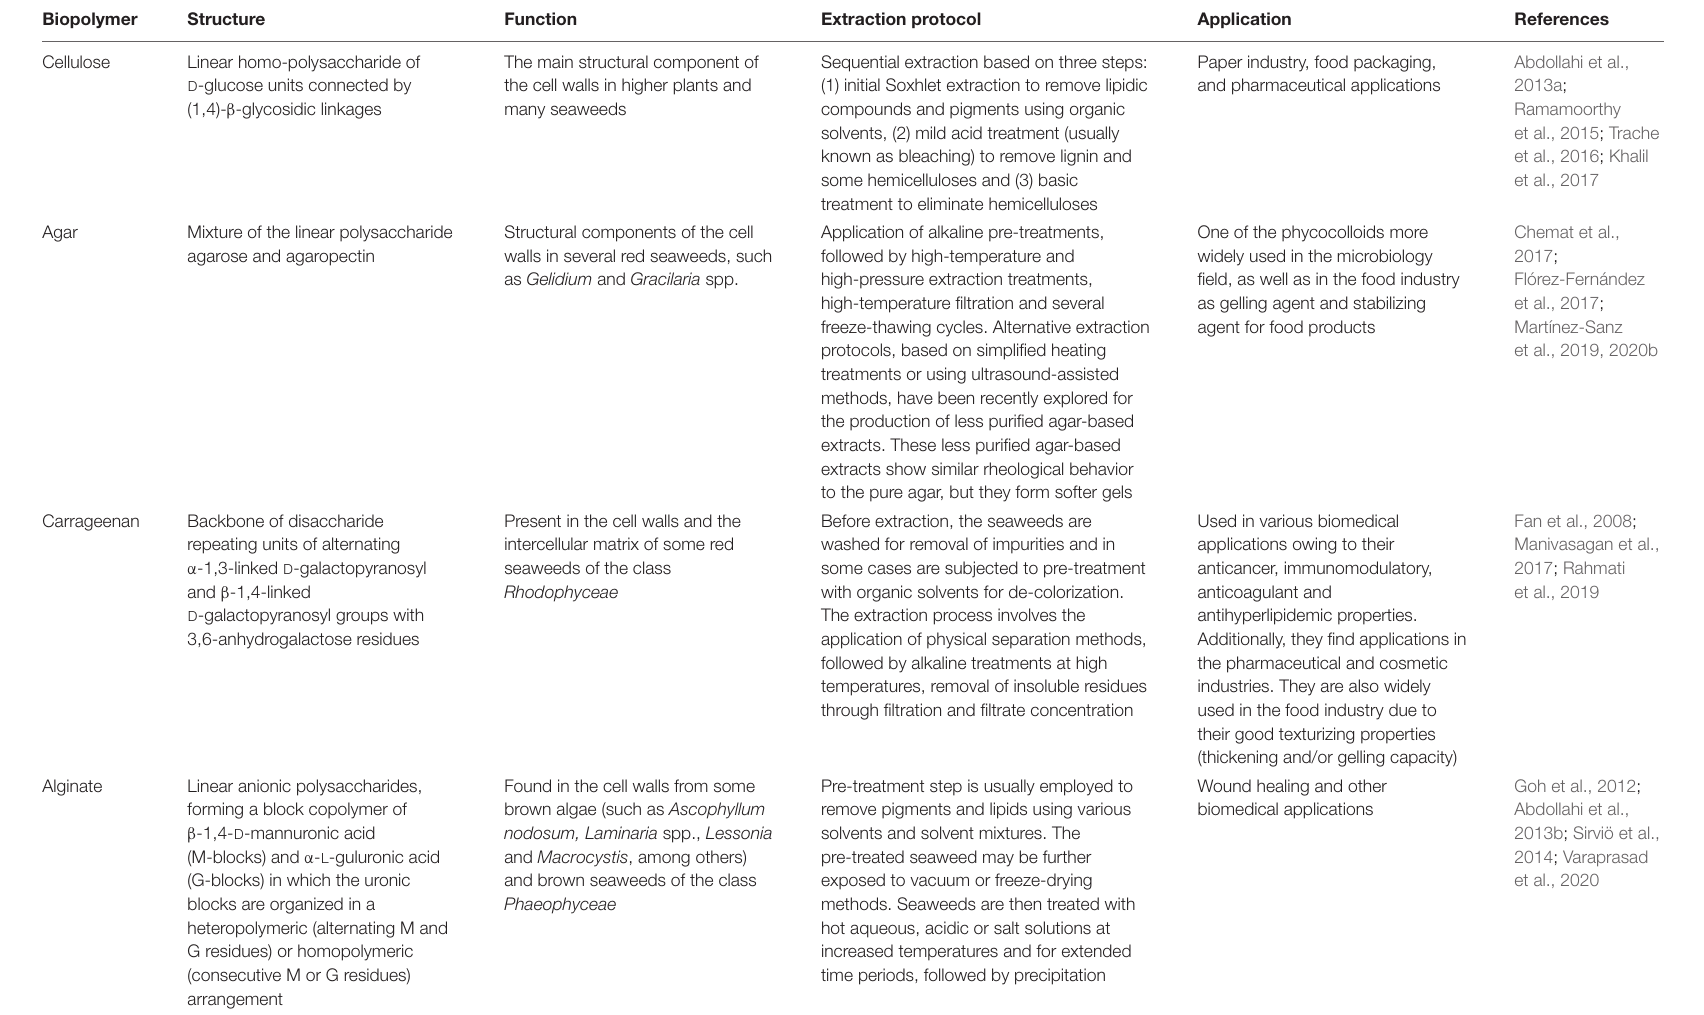
TABLE 3 | The main marine biopolymers and their use.